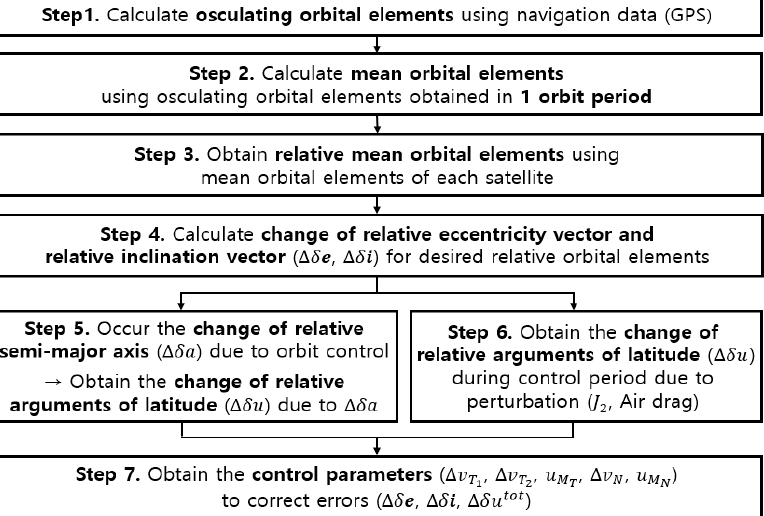
Figure 4. Flowchart of the relative orbit control algorithm for formation maintenance using relative orbital elements.